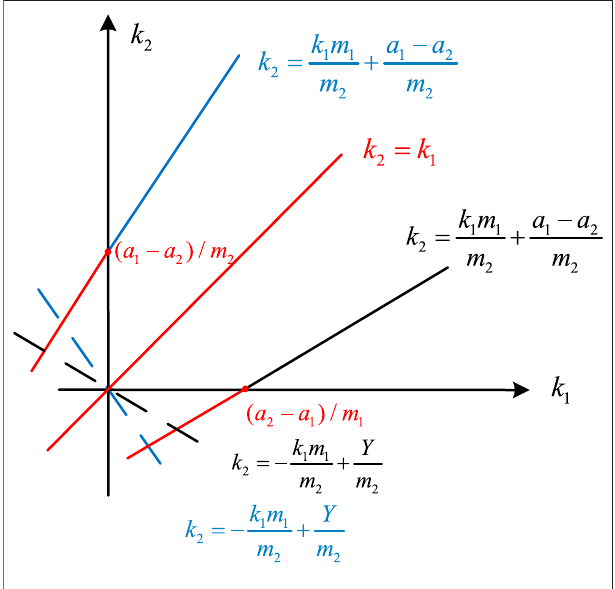
FIGURE 7 | Schematic diagram in case of a 1 (cid:2) a 2 .